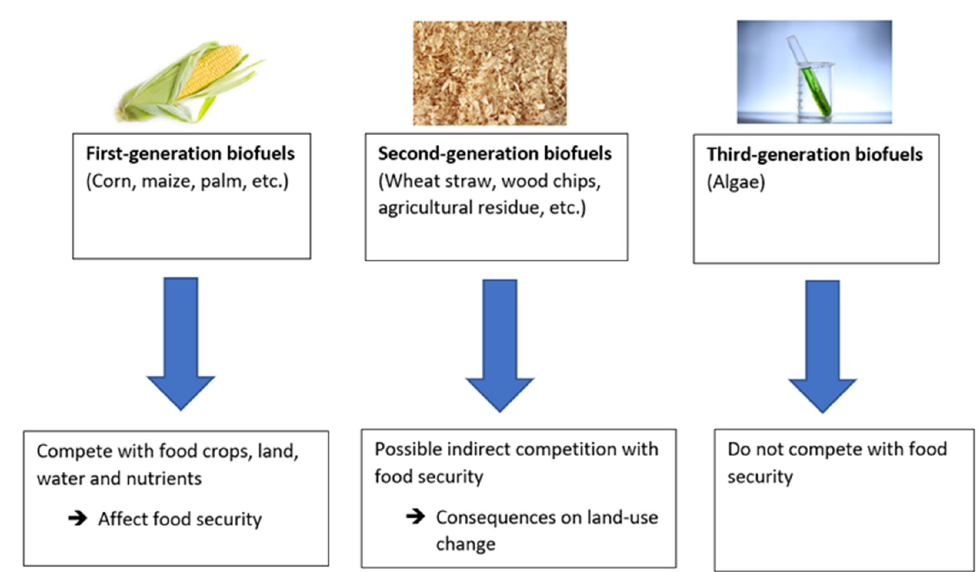
Figure 2. Different impacts of biofuel sources on food security and land-use change.